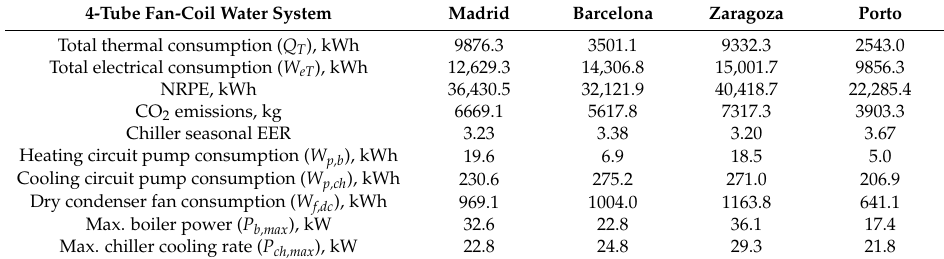
Table 2. 4-Tube Fan-coil system: Annual energy consumption and mean efficiency parameters.